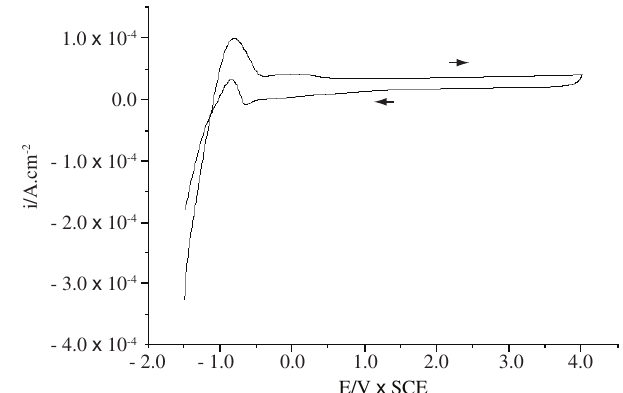
Figure 6. Voltammetric curve of Ti in fluoride-containing citric acid from - 1.0 to 4.0 V at 0.05 Vs -1 .